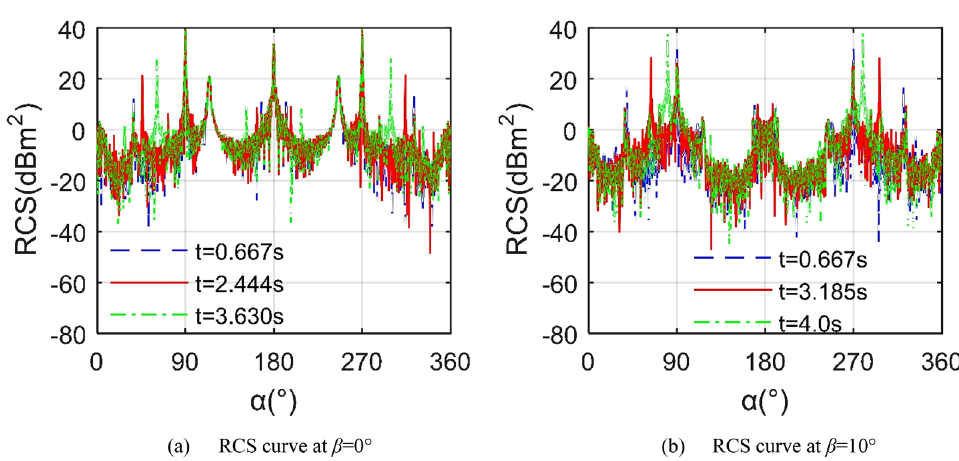
Figure 9. RCS of the aircraft in Z1 mode, f RH = 6 GHz, ω r1 = ω r2 = 0.3142 rad/s, A m1 = A m2 =